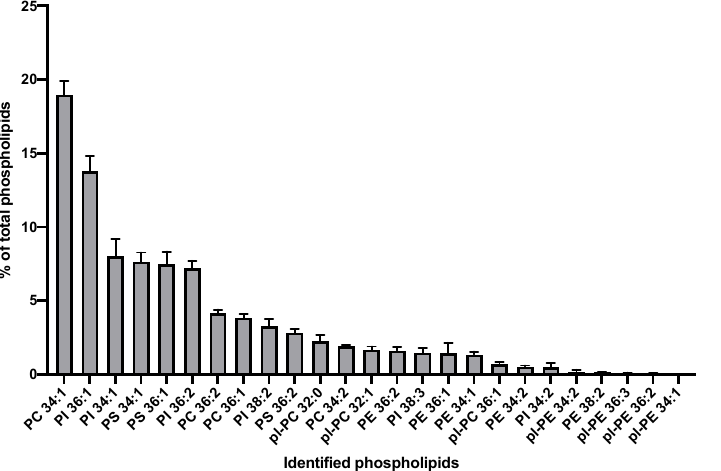
Figure 4. Phospholipids identified in C92 EV SEC . PC: phosphatidylcholine, PI: phosphatidylinositol, PS: phosphatidylserine, pl-PC: plasmalogen-phosphatidylcholine, PE: phosphatidylethanolamine, pl-PE: plasmalogen-phosphatidylethanolamine. Error bars indicate standard error of the mean (SEM).